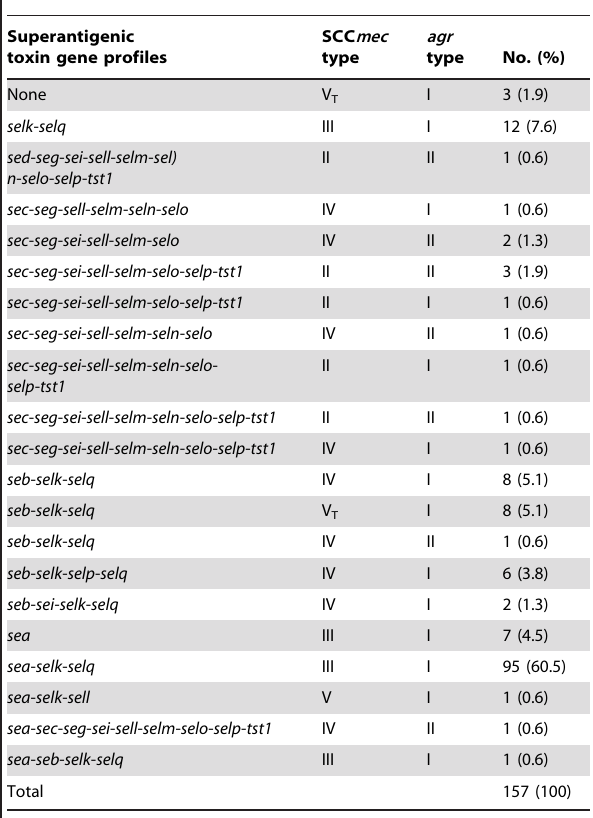
Table 3. Association of superantigenic toxin gene profiles with different SCC mec types and agr groups of MRSA blood isolates.